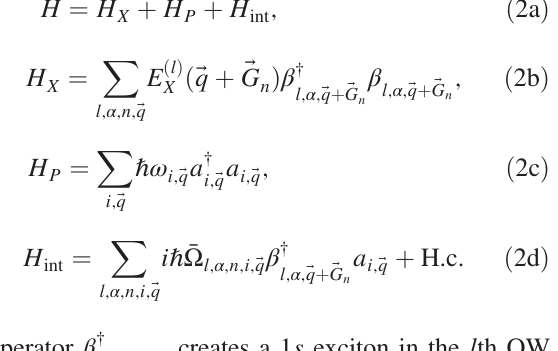
Here, ε 0 is the vacuum permittivity, S is the area of the structure in the x - y plane, ~r ¼ ð ~ ρ ; z Þ with ~ ρ ¼ ð x; y Þ , and ω is the frequency of a photon in the i th band with i;~q a Bloch wave vector ~q in the 2D Brillouin zone − π ≤ q ; q < π . The field is normalized such that x y a a